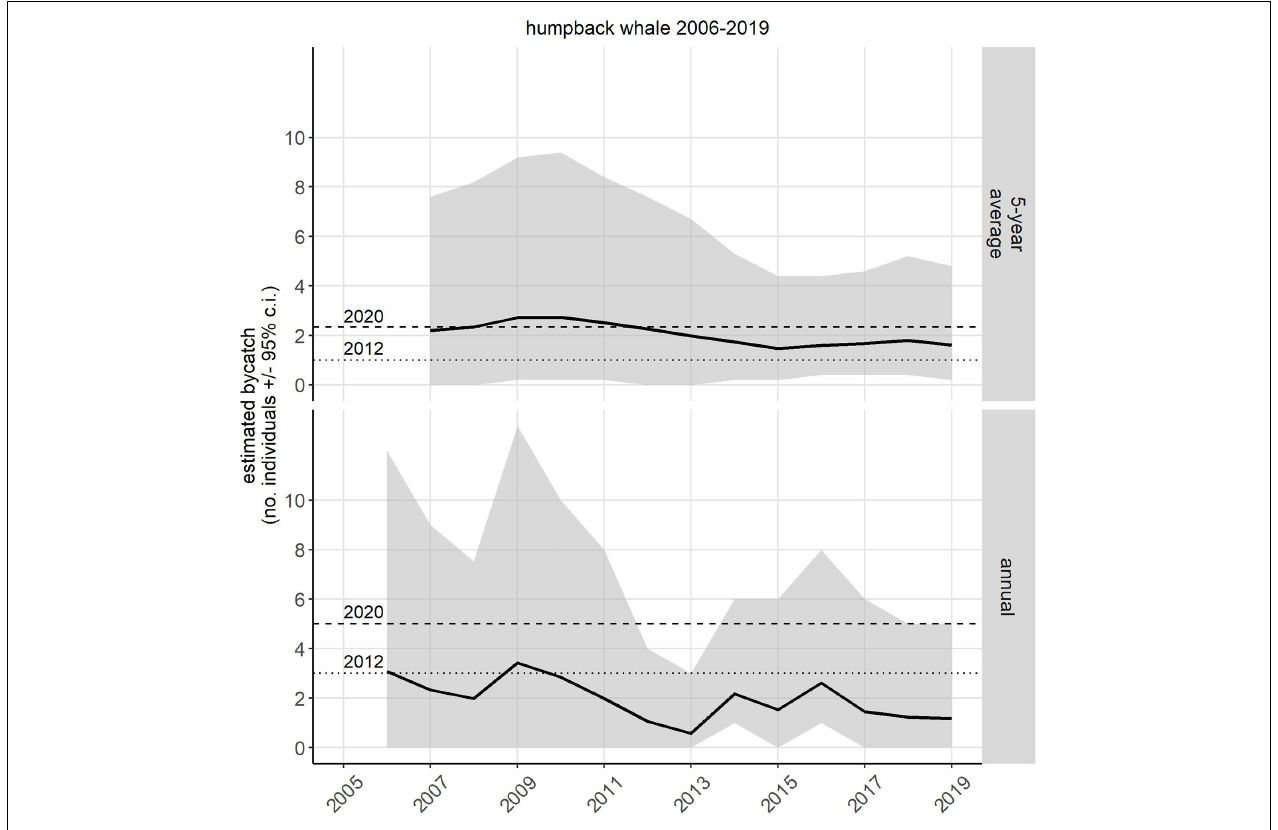
FIGURE 1 | Estimated bycatch [number of individuals, 95% credible interval (CI)] of humpback whales in the United States West Coast sablefish pot fishery. Estimates were made for LE and OA sectors separately and then the estimates from the two sectors were summed. The two Biological Opinions (2012 and 2020) governing the incidental take of humpback whales in this fishery specified a 5-year average (top panel) in 2012 (dotted line) as 1 whale/year, and 2.34 whales/year in 2020. The specified annual take threshold (bottom panel) in 2012 (dotted line) was 3 whales/year and in 2020 (dashed line) was 5